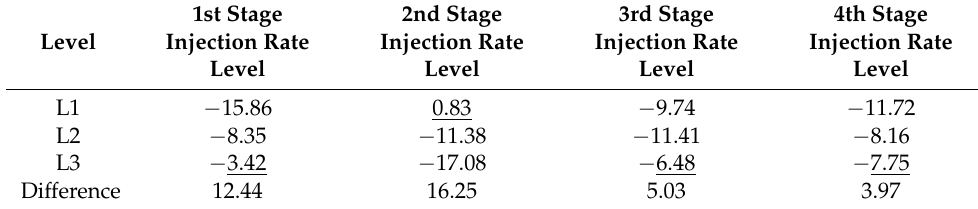
Table 6. Taguchi response table.